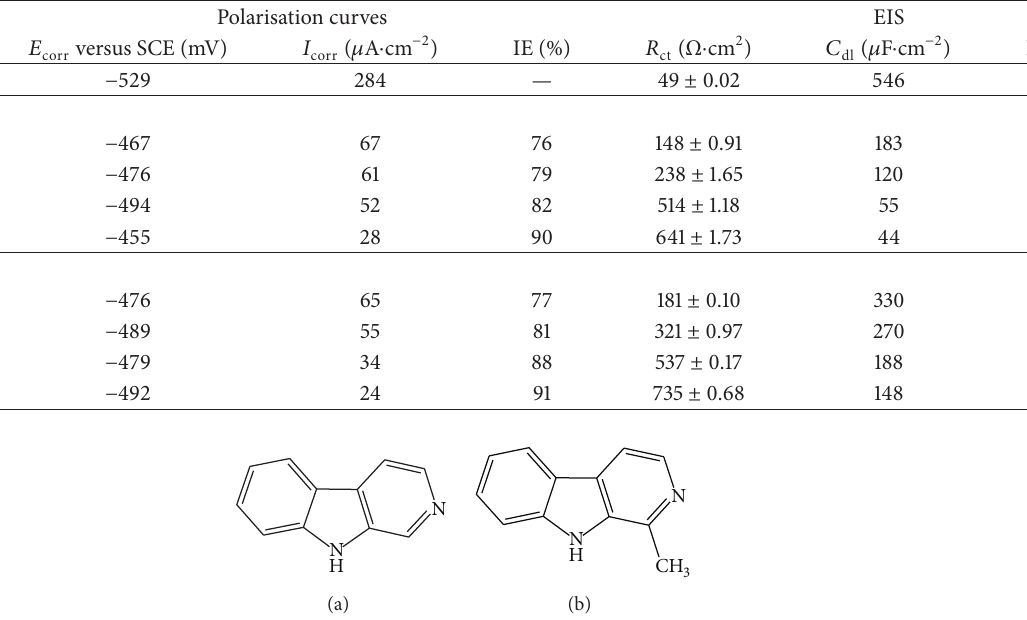
Figure 1: Chemical formulas of the tested inhibitors (a) norharmane and (b)